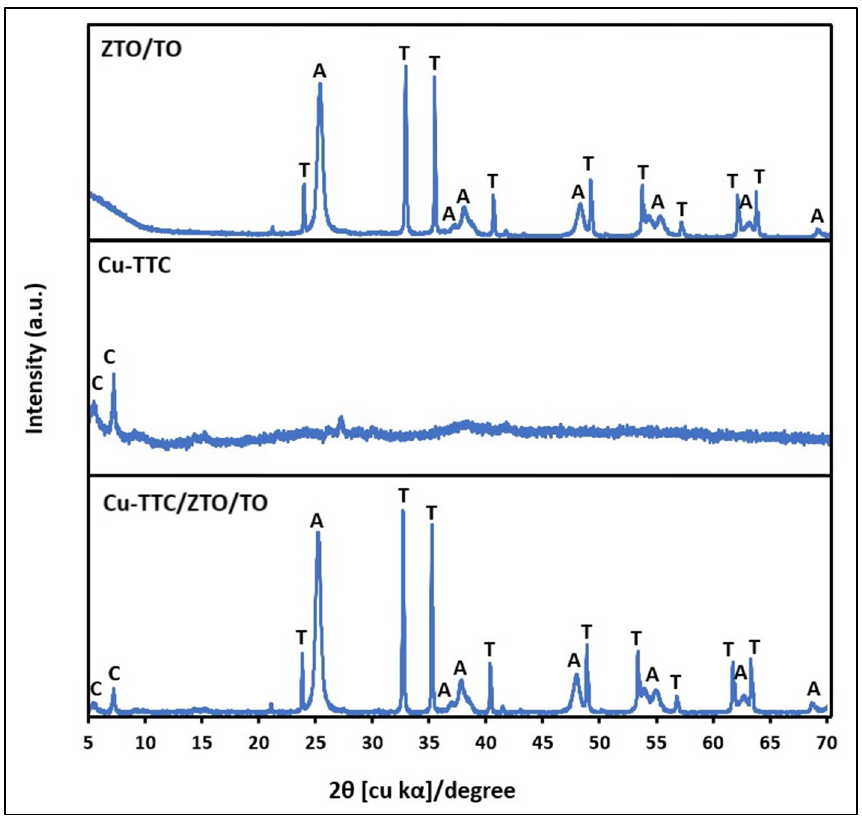
Figure 2. XRD of ZTO/TO, Cu-TTC and Cu-TTC/ZTO/TO. C : Cu-TTC; T: ZnTiO 3 ; A: TiO 2-a .